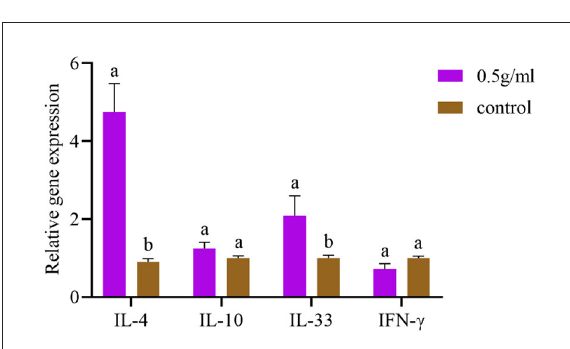
FIGURE3 Effects of orally administered DBD on spleen cytokine mRNA expression in mice. a,b Values in the same column with different superscript letters differ significantly at P < 0.05 .